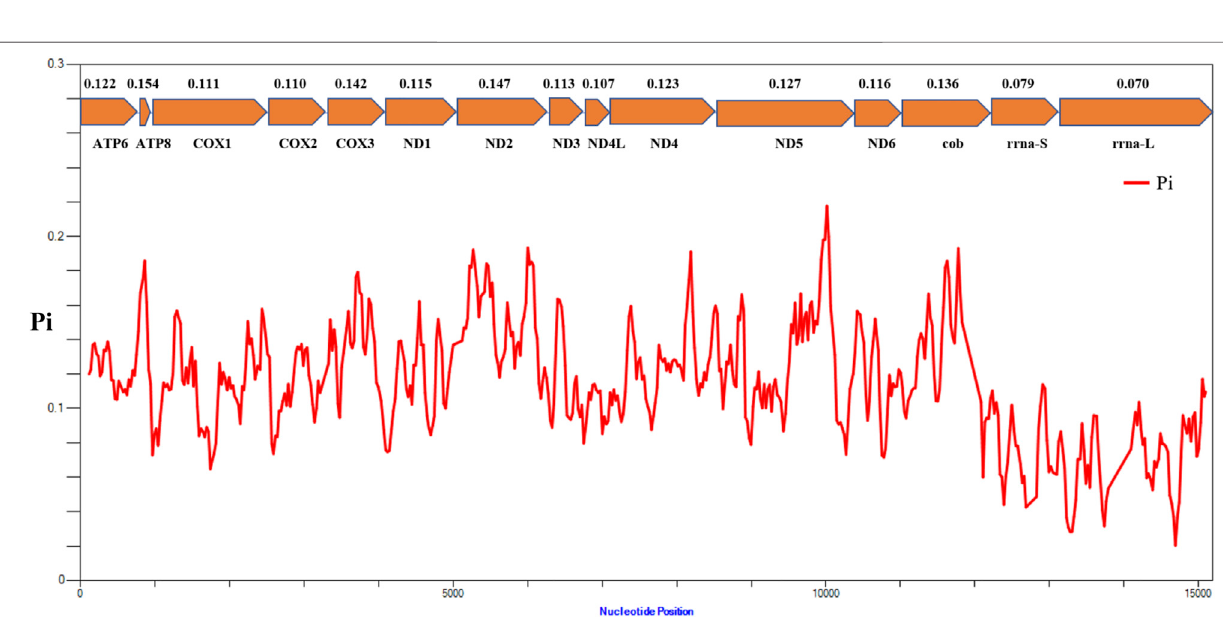
Frontiers in Genetics |